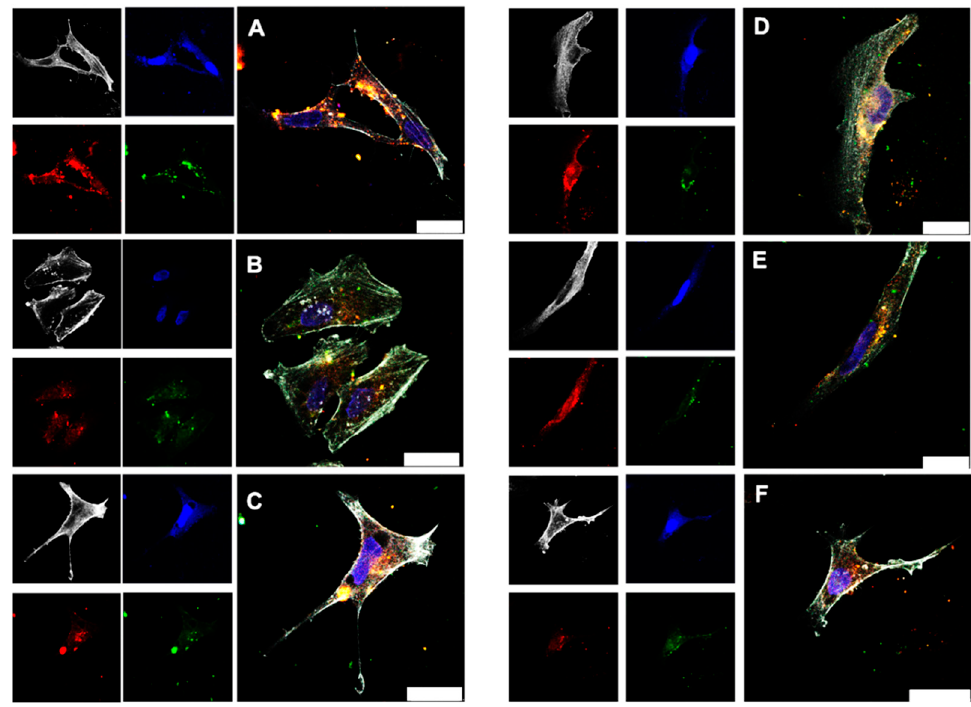
Figure 11. Confocal laser scanning microscopy images of HeLa cells incubated for 24 h with dispersed Au-BSA-AF555 nanoclusters (13.3 µg mL − 1 Au) ( A ). The uptake of Au-BSA-AF555 nanoclusters from dissolved capsules is shown in ( B ) for Eudragit (14.5 µg mL − 1 Au), in ( C ) for CAP (15.4 µg mL − 1 Au), in ( D ) for HPMC-Eudragit (17.0 µg mL − 1 Au), and in ( E ) for HPMC-PVA-Eudragit (16.5 µg mL − 1 Au). ( F ) The uptake of Au-BSA-AF555 nanoclusters after release from a suppository (22 µg mL − 1 Au). Grey: actin; blue: nucleus; green: Au-BSA autofluorescence; red: Au-BSA-AF555 fluorescence from AF555. Scale bar 25 µm.